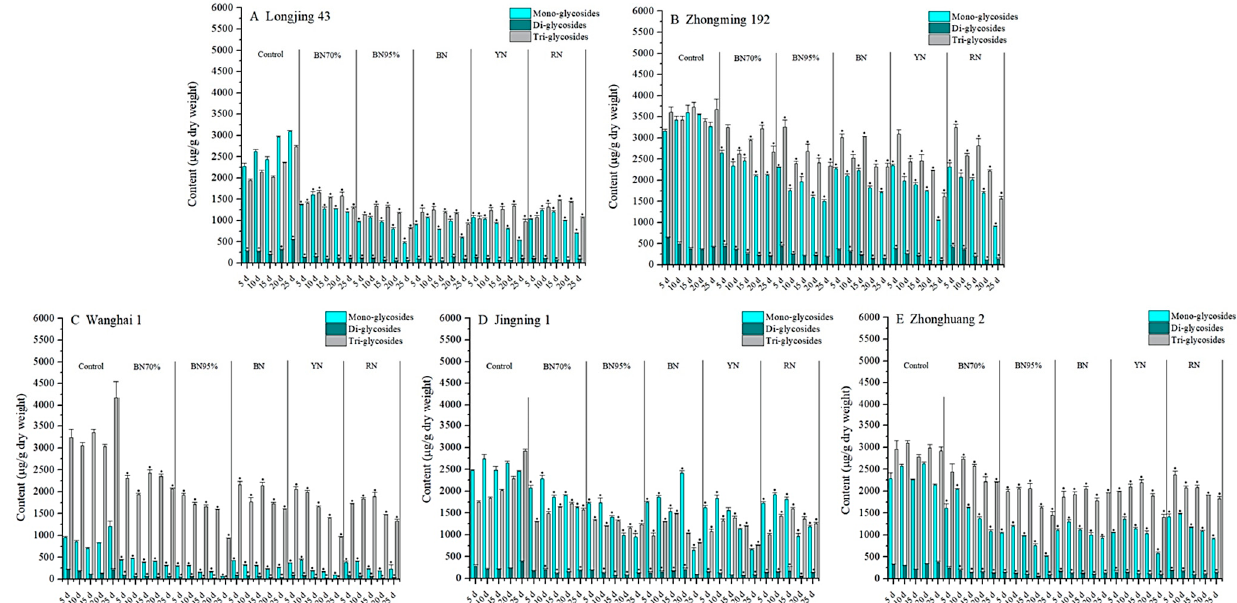
Figure 5. Impacts of different shade treatments on the contents of flavonol glycosides classified by sugar moiety. For the same tea cultivars harvested on the same day, data annotated with * were significantly different from the corresponding CK ( p < 0.05). Significant difference analysis was carried out using the TTEST function of Microsoft Excel for Mac (version 16.54, Microsoft Corporation, Redmond, WA,